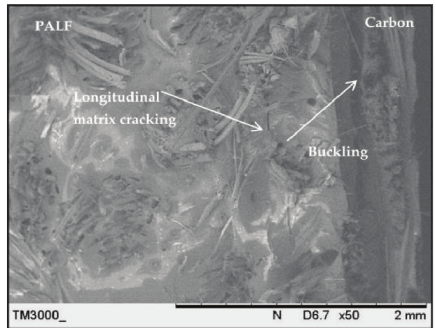
Figure 8: SEM image of the laminate with a carbon ply exterior (CPPC) and ply orientation [0 ° , 90 ° ]